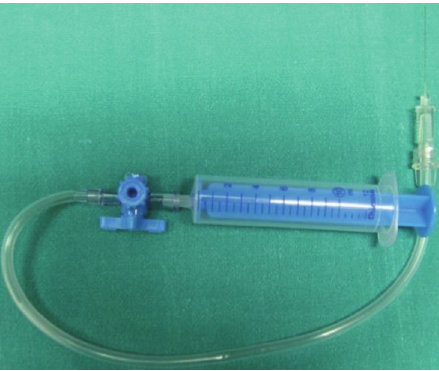
Figure 1: Set for manual Fine-needle aspiration biopsy/cytology, composed of 10 mL syringe, extension tube with a three-way stopcock, and long 27-gauge